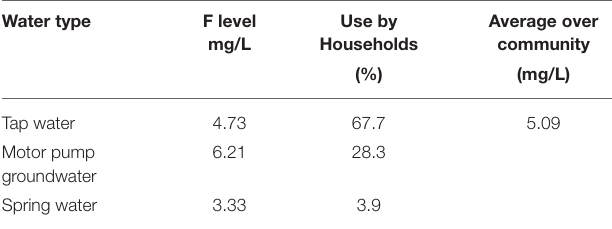
TABLE 2 | Fluoride (F) levels of water collected from different sources from Halaba SNNPR, Ethiopia, 2019.